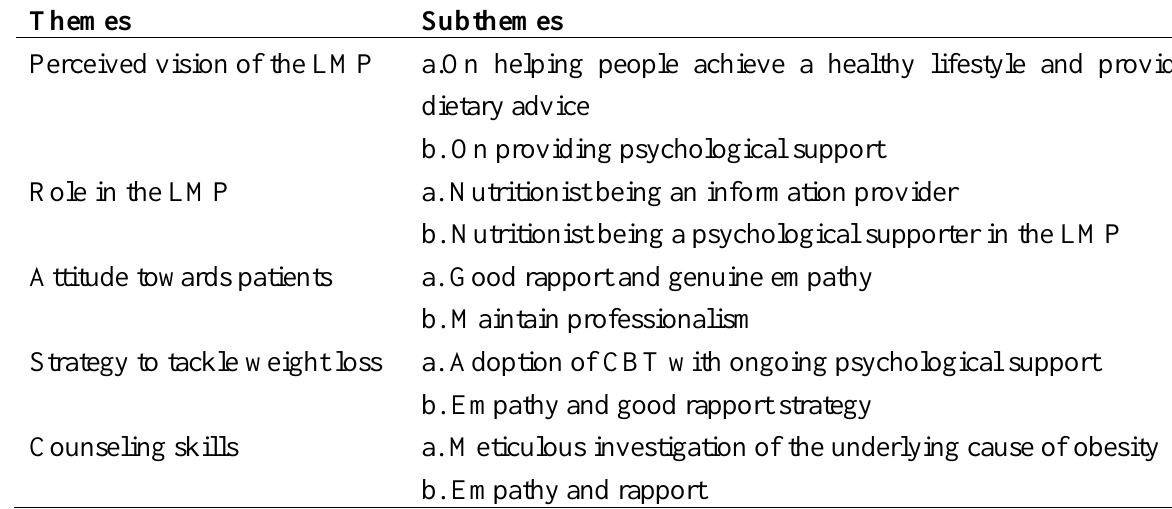
Table 4. Themes identified by researchers from analysis of transcribed